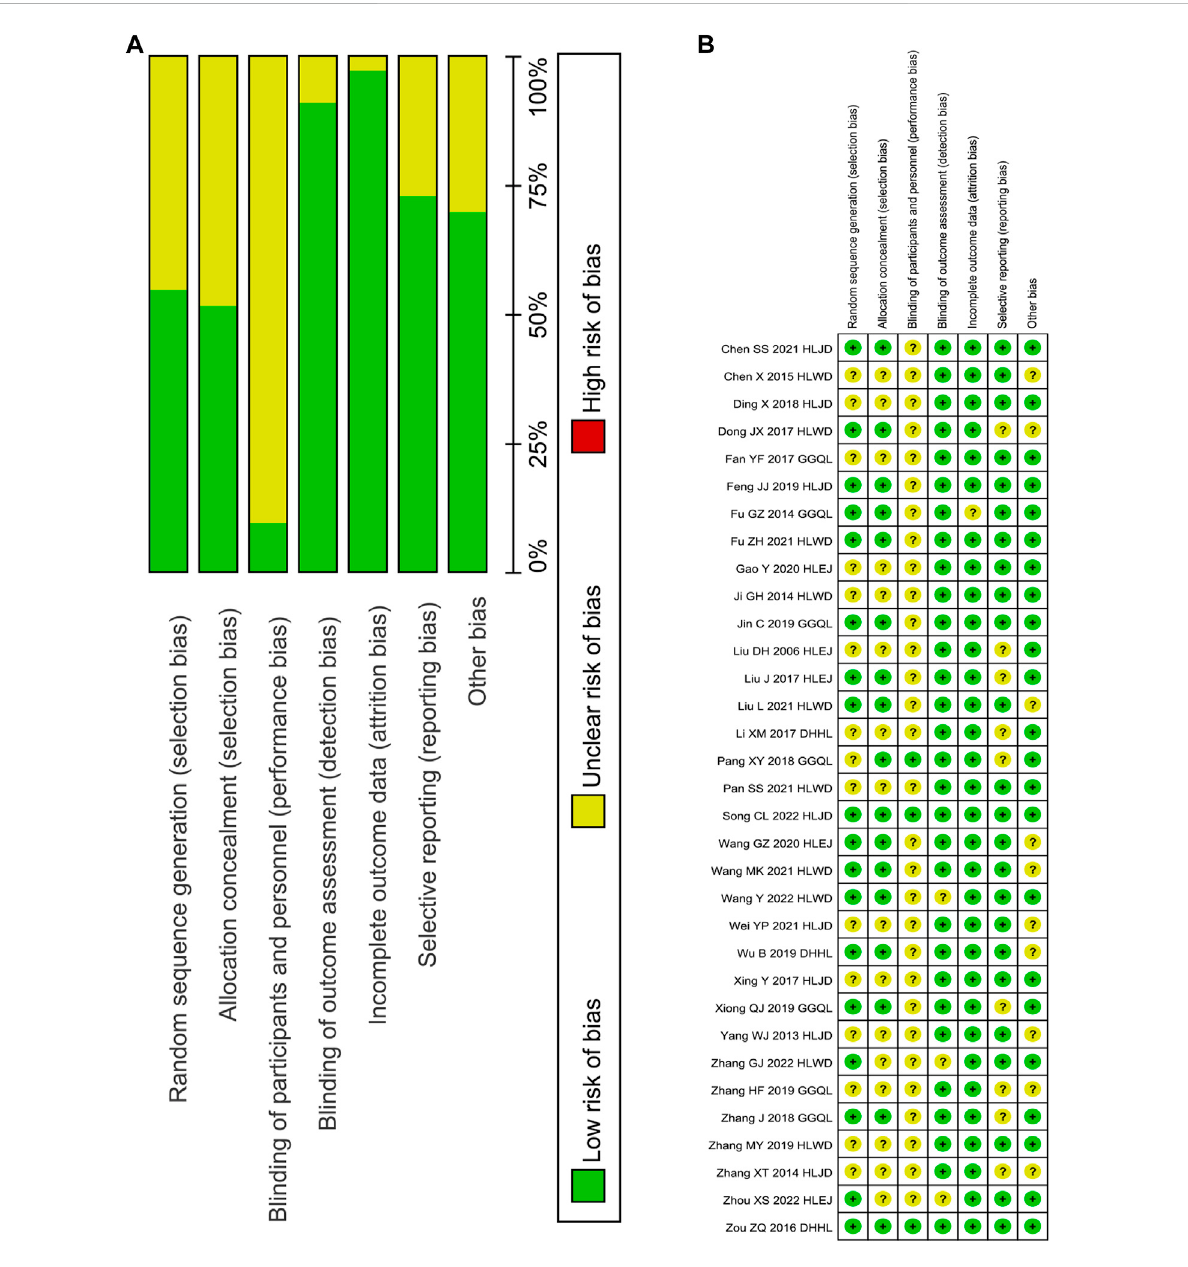
FIGURE 2 Risk of bias graph. Note: (A) , judgements about each risk of bias item presented as percentages across all included studies; (B) , judgements about each risk of bias item for each included study.